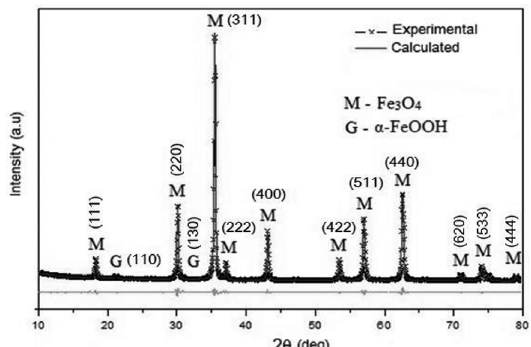
Figure 2. Rietveld refinement of sample